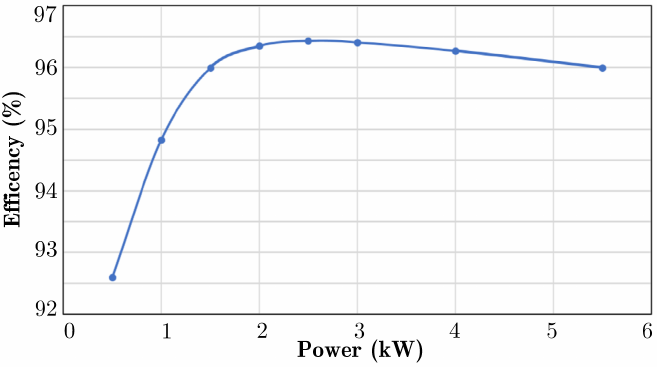
Figure 18. Efficiency curve of the power stage of a FB VSI for an input voltage of 180 V in